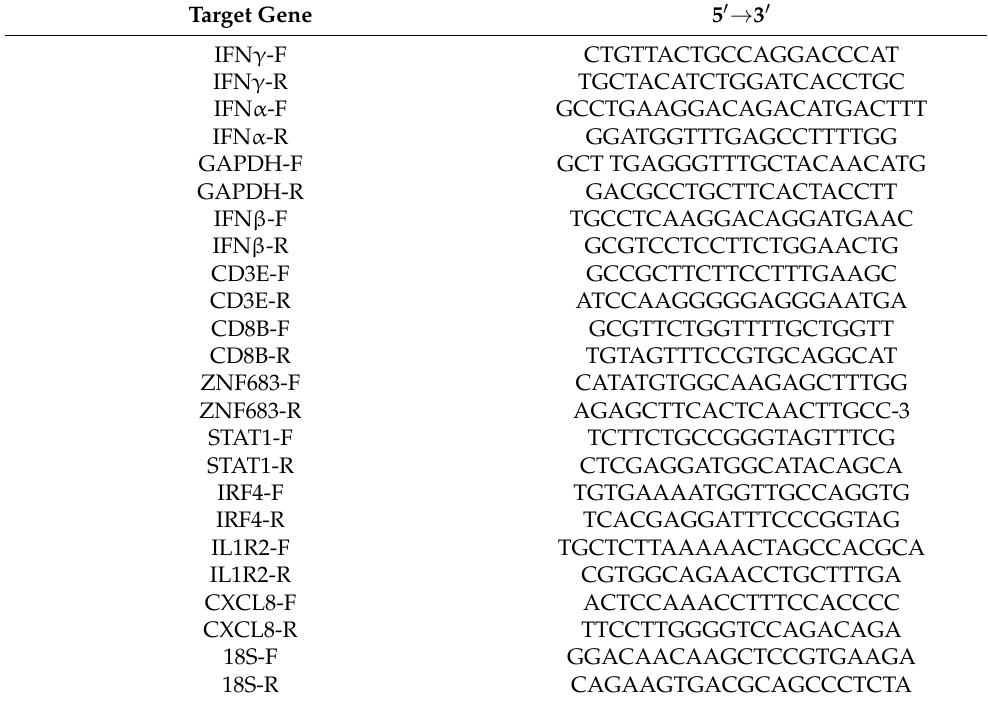
Table 1. Primers used to amplify related genes. Target